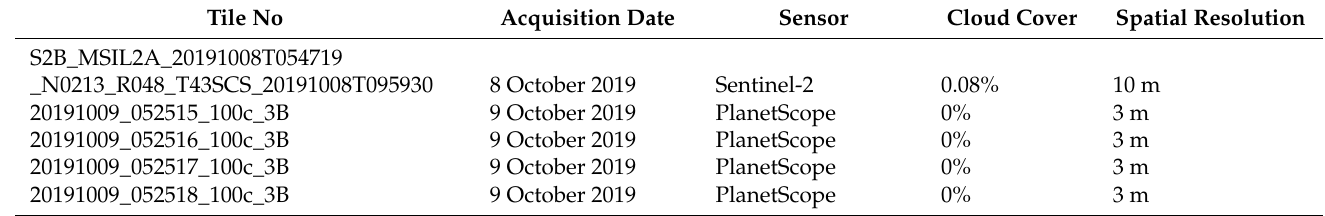
Table 2. An overview of product images of the study area obtained from different